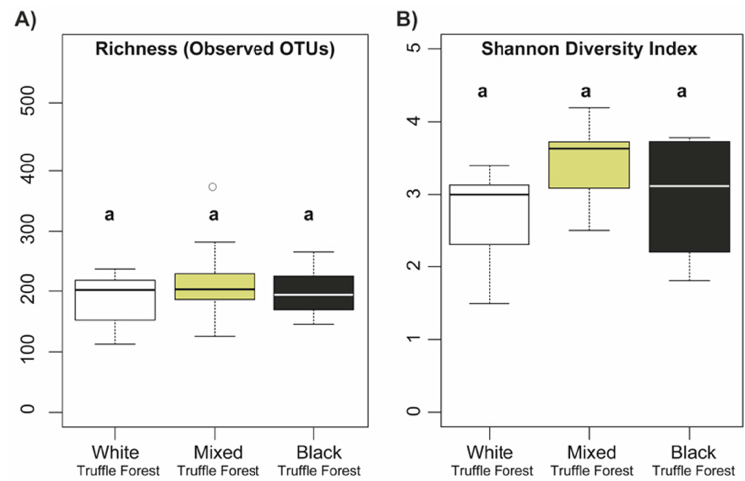
Figure 1. Observed richness (number of OTUs) ( A ) and Shannon diversity index ( B ) of root-associated mycobiome in white, mixed, and autumn black truffle-producing forest in Serbian riparian forests. Significant differences in observed richness and Shannon diversity Index between different truffle-producing forests were calculated using one-way ANOVA followed by Tukey’s HSD test ( p > 0.05).